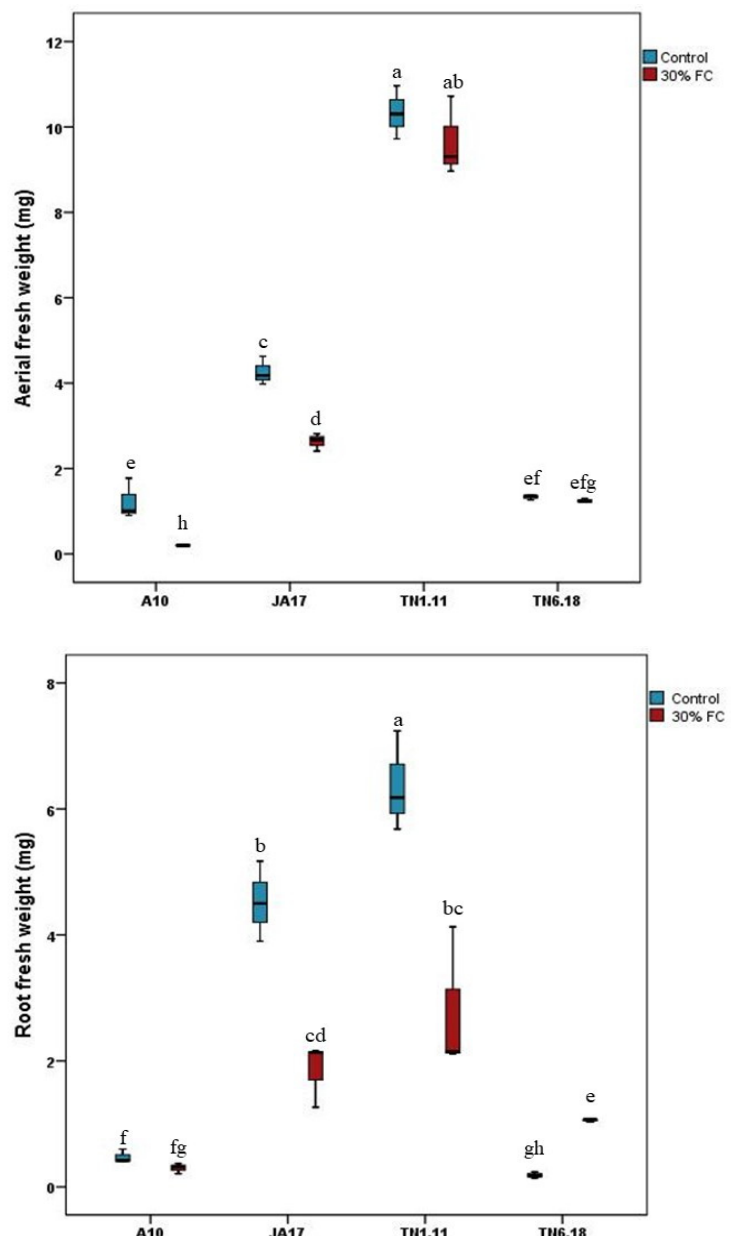
Figure 2. Means of shoot and root fresh weights for the four lines of M. truncatula under control and 30% FC. Means followed by the same or a common letter (s) are not significantly different among the studied lines for each trait according to Duncan’s test at 5%.